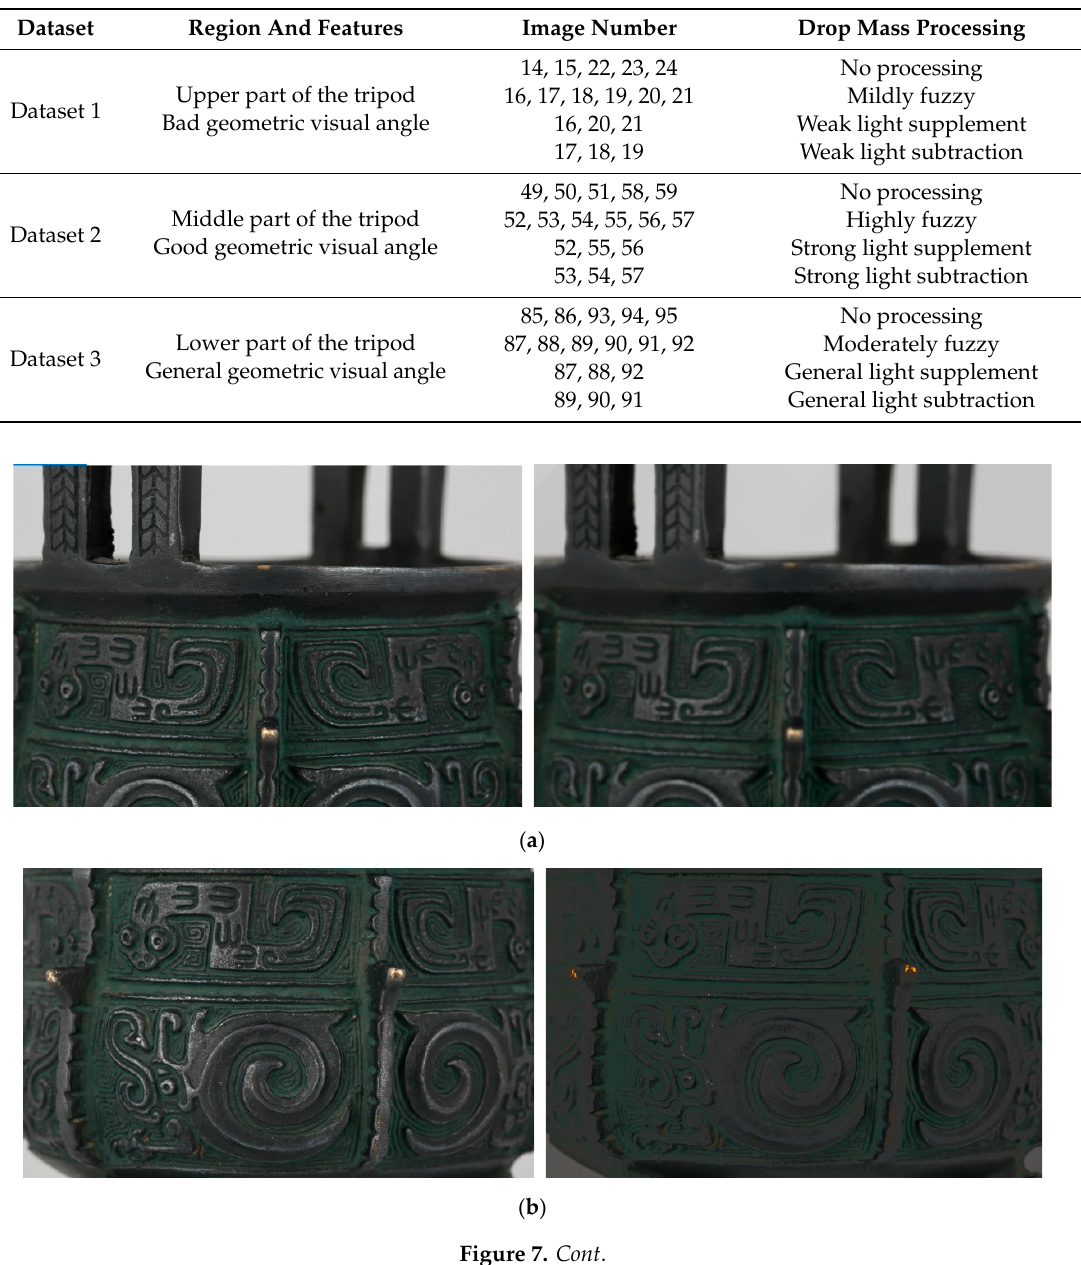
Table 1. Image dataset.